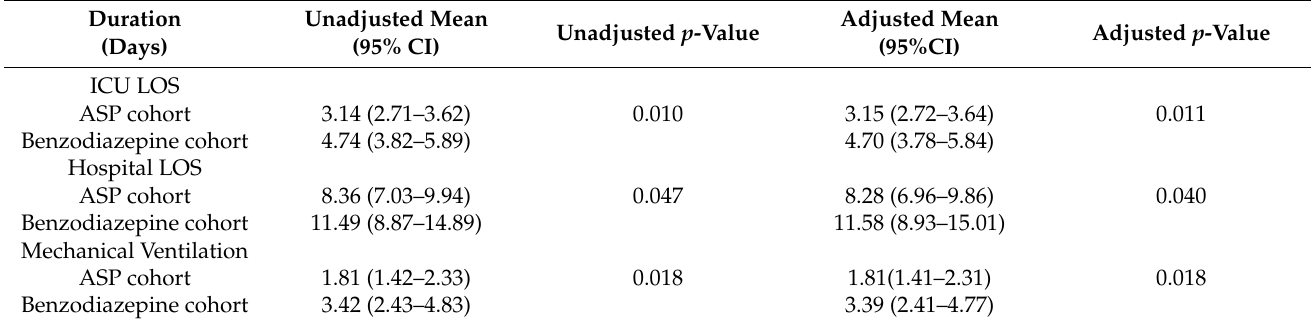
Table 3. Comparison of Outcomes between ASP cohort and Benzodiazepine